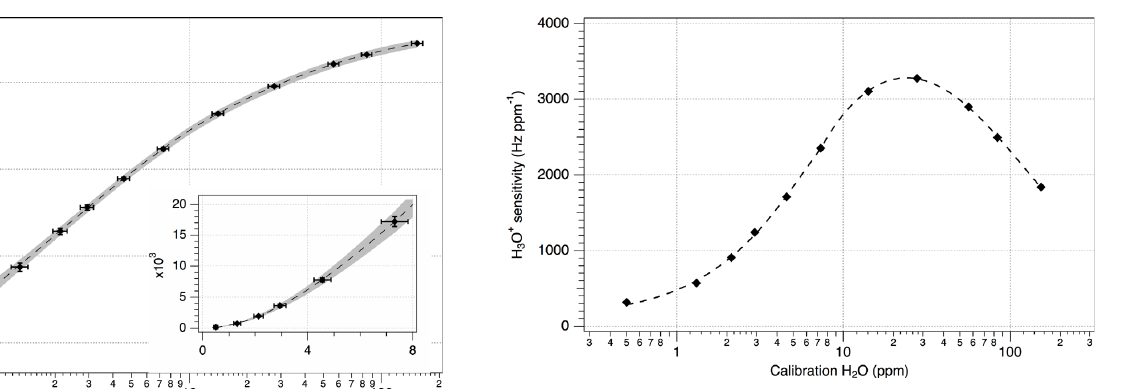
Fig. 7. The sensitivity of the CIMS measurement as a function of the H 2 O mixing ratio from the calibration shown in Fig. 6. The diamonds are the values from the individual calibration points, and the dashed line is the curve